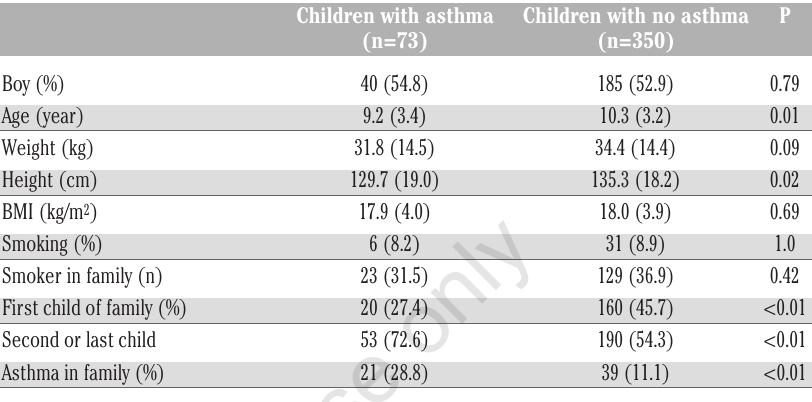
Table 1. Demographic data of asthmatic children and control group.